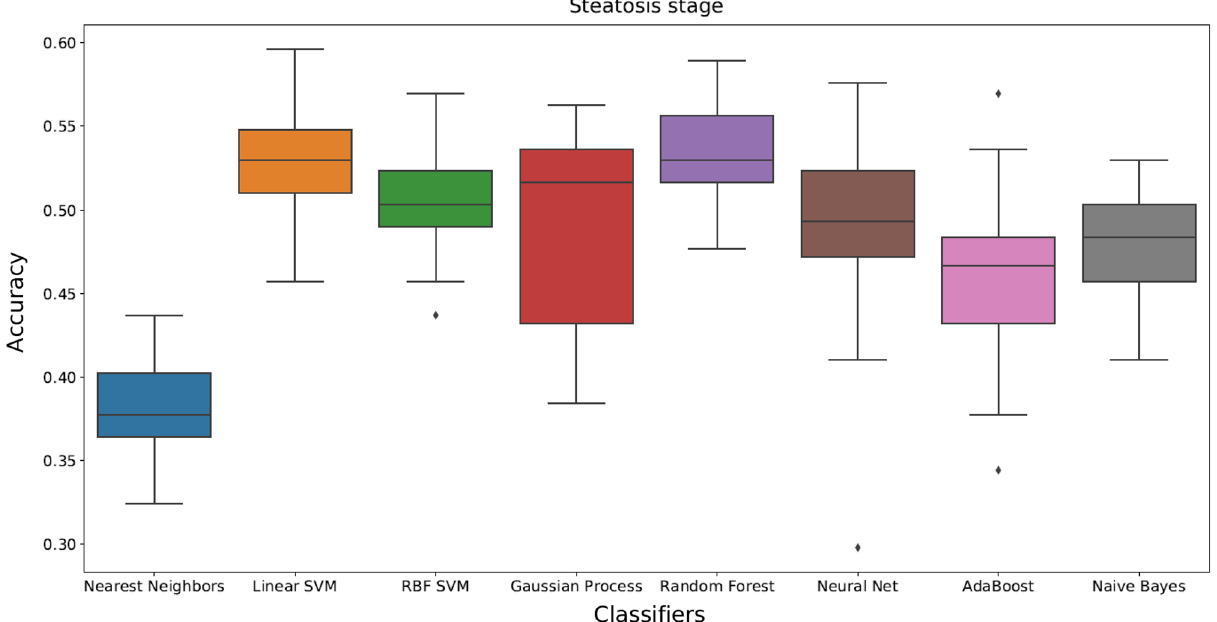
Figure 2. Box plots showing different classification methods applied to the dataset for stages of steatosis. Box plots are generated by performing 50 individual runs for each classifier. This will assure that the achieved results are